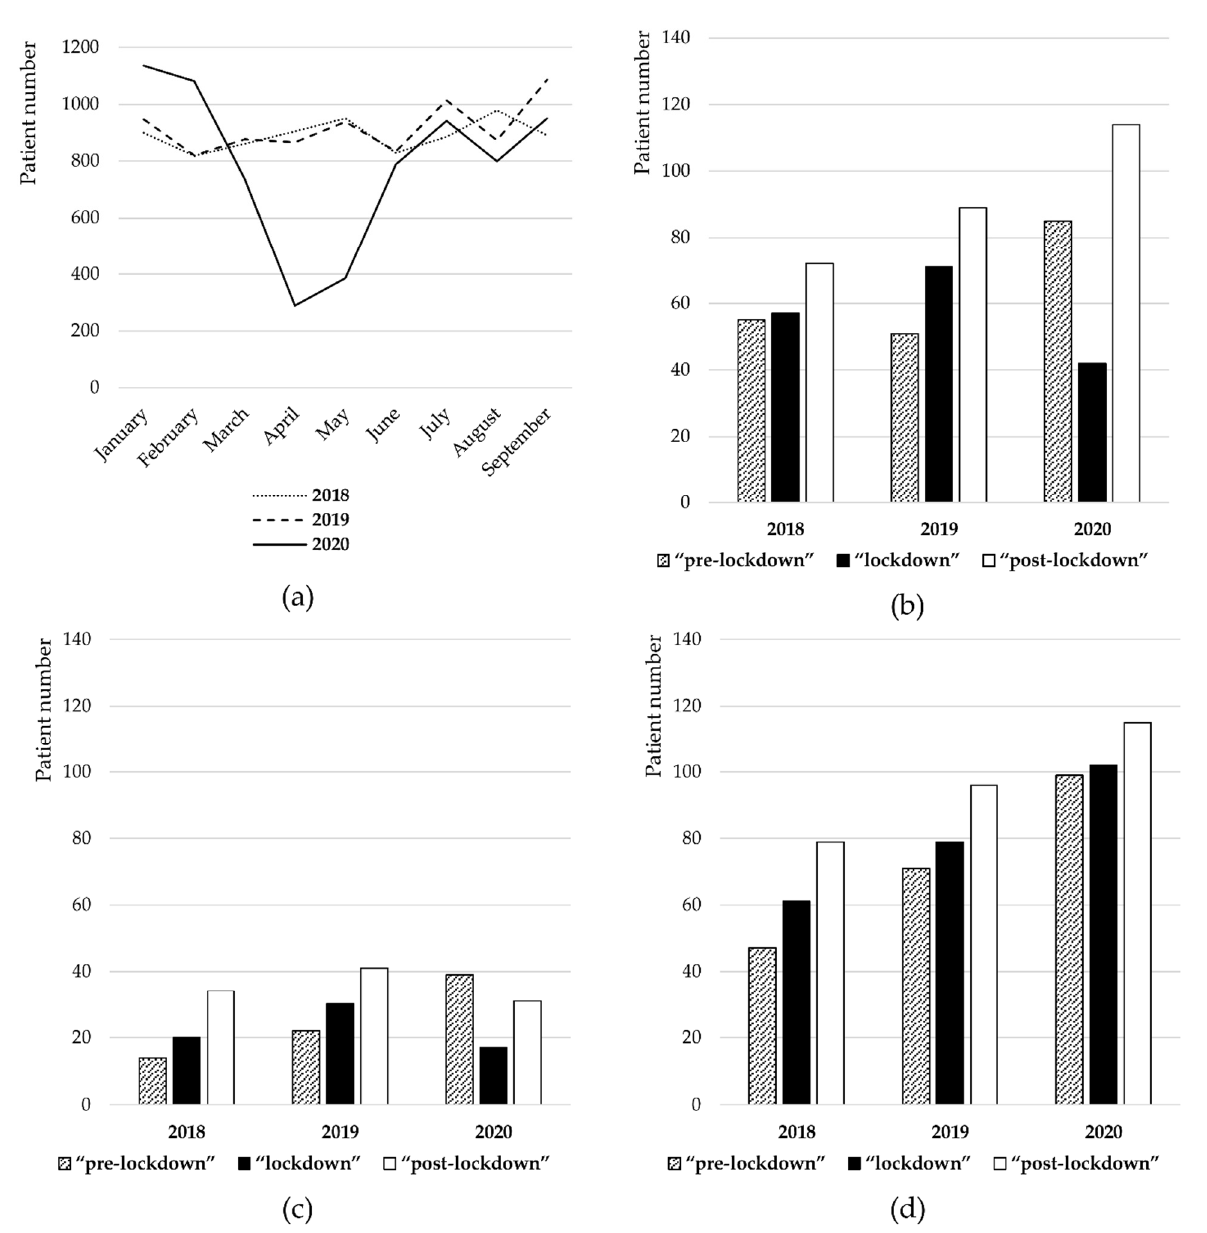
Figure 1. ( a ) The number of STI patients from 1 January to 30 September. ( b ) The number of patients with syphilis in the “pre-lockdown” (1 January–27 March), “lockdown” (28 March–18 June), and “post-lockdown” (19 June–30 September) periods of 2018, 2019, and 2020, respectively. ( c ) The number of patients with chlamydia in the “pre-lockdown” (1 January–27 March), “lockdown” (28 March–18 June), and “post-lockdown” (19 June–30 September) periods of 2018, 2019, and 2020, respectively. ( d ) The number of patients with gonorrhea in the “pre-lockdown” (1 January–27 March), “lockdown” (28 March–18 June), and “post-lockdown” (19 June–30 September) periods of 2018, 2019, and 2020, respectively.